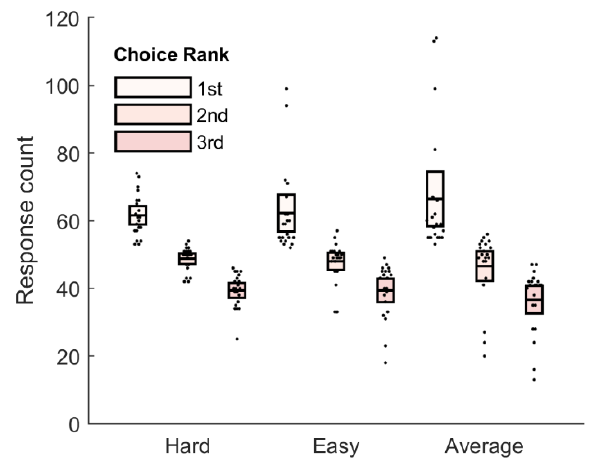
Figure 3. Behavioural data. Mean response count as a function of ranked preference against each of the hard, easy, and average opponents.